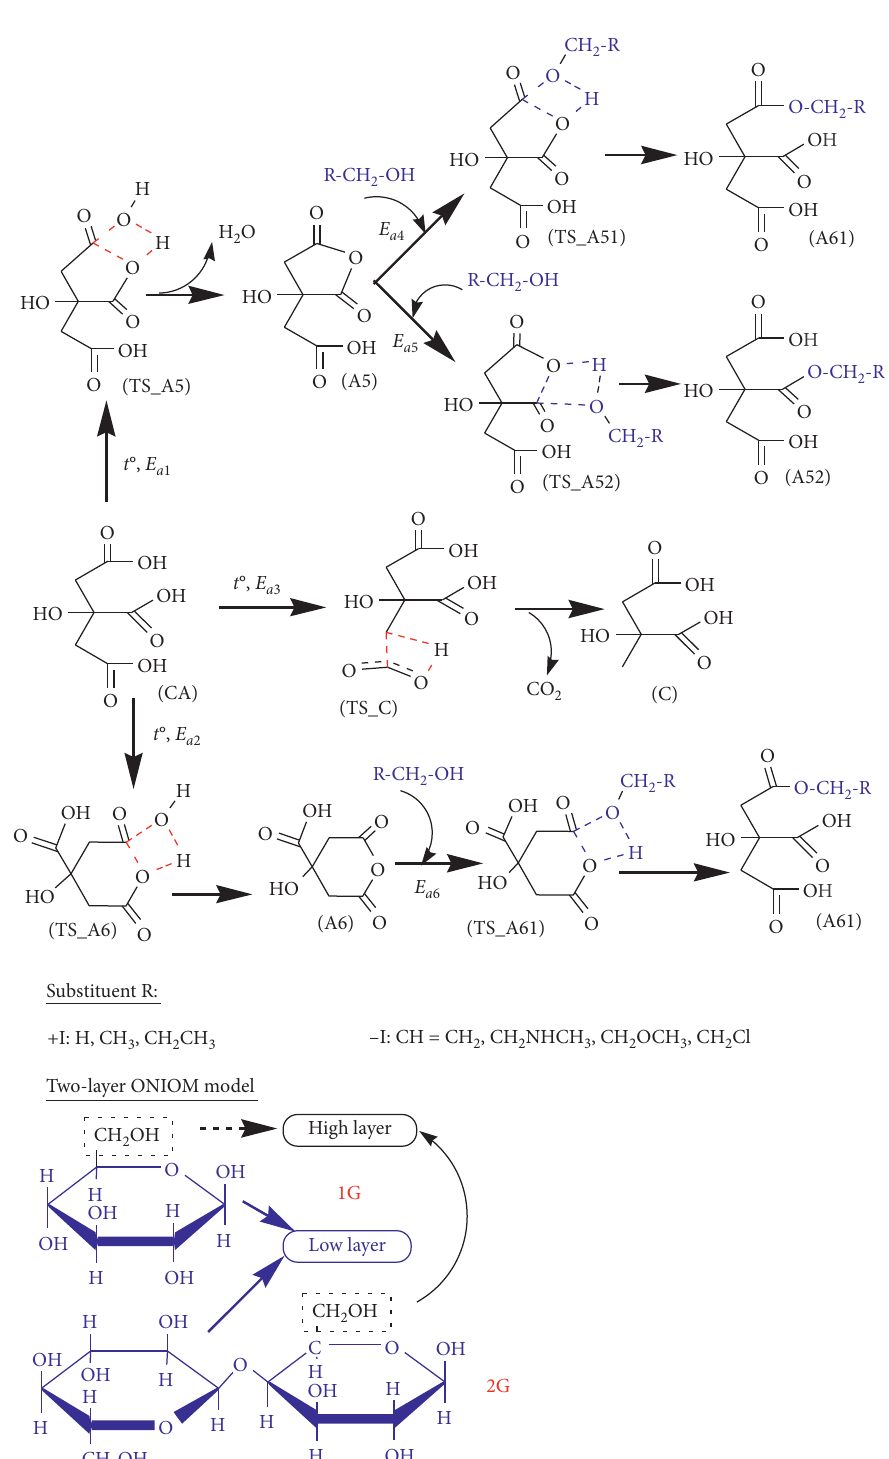
Figure 2: Possible esterification mechanisms of CA with the primary alcohols and the hydroxyl groups of cellulose chain ( n � 1-2) in parched